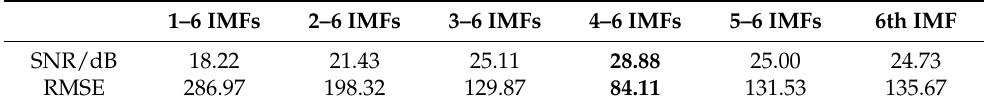
Table 4. Denoising performance of layer-by-layer accumulating of